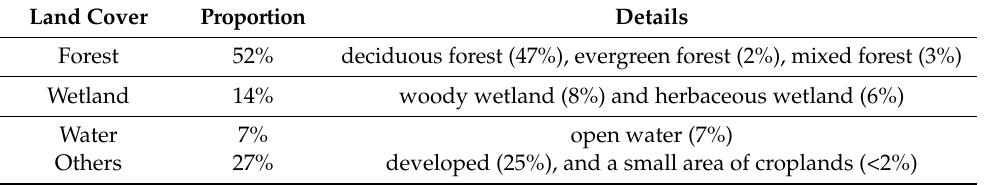
Table 1. The proportion of land cover types in the study area. Land Cover